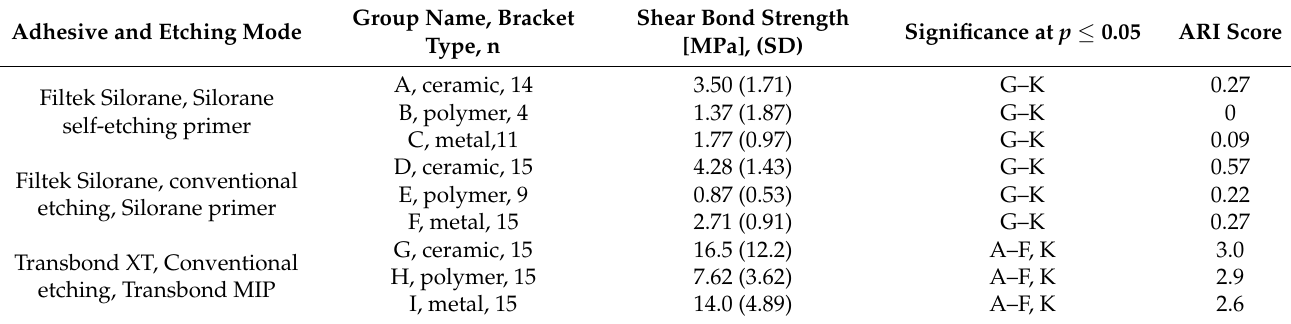
Table 1. Comparison of the mean shear bond strength [N], standard deviations (SD) and ARI. The column significance shows differences according to the shear bond strength ( p ≤